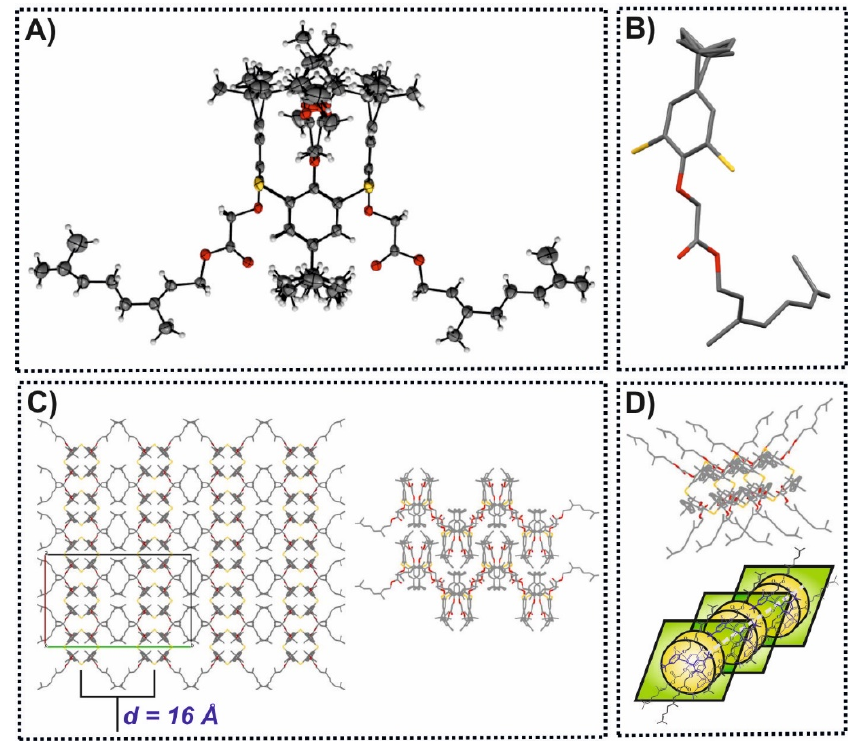
Figure 3. X-ray structure of 5 ( A ) showing the 1,3-alternate conformation (gray—carbon atoms, white—hydrogen atoms, yellow—sulfur atoms, red—oxygen atoms), asymmetric unit ( B ), crystal packing (the rectangle is the elementary cell) ( C ), stack of molecules in crystals 5 ( D ). H atoms and disorder are not presented for clarity in ( B – D ).